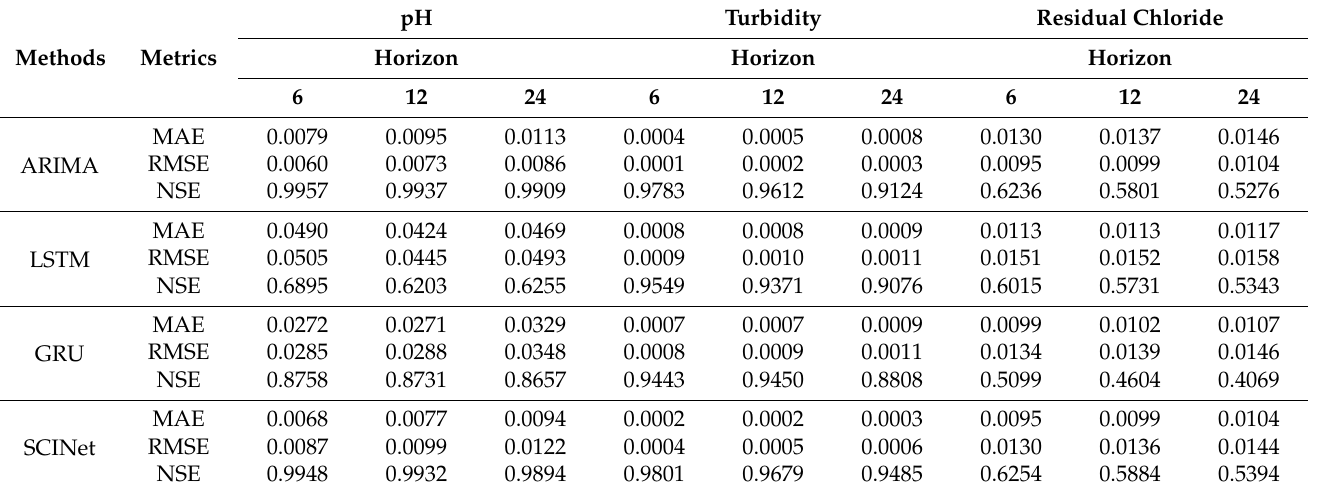
Table 7. Baseline comparisons under multi-step setting for best practices of time series forecasting